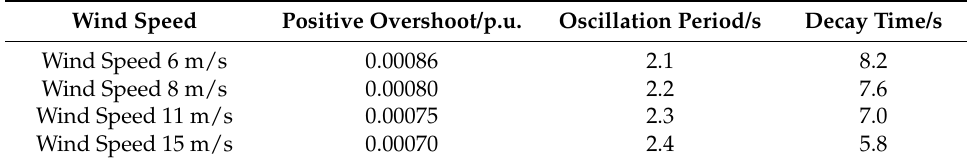
Table 5. Dynamic performance of novel DFIG damping control under different wind